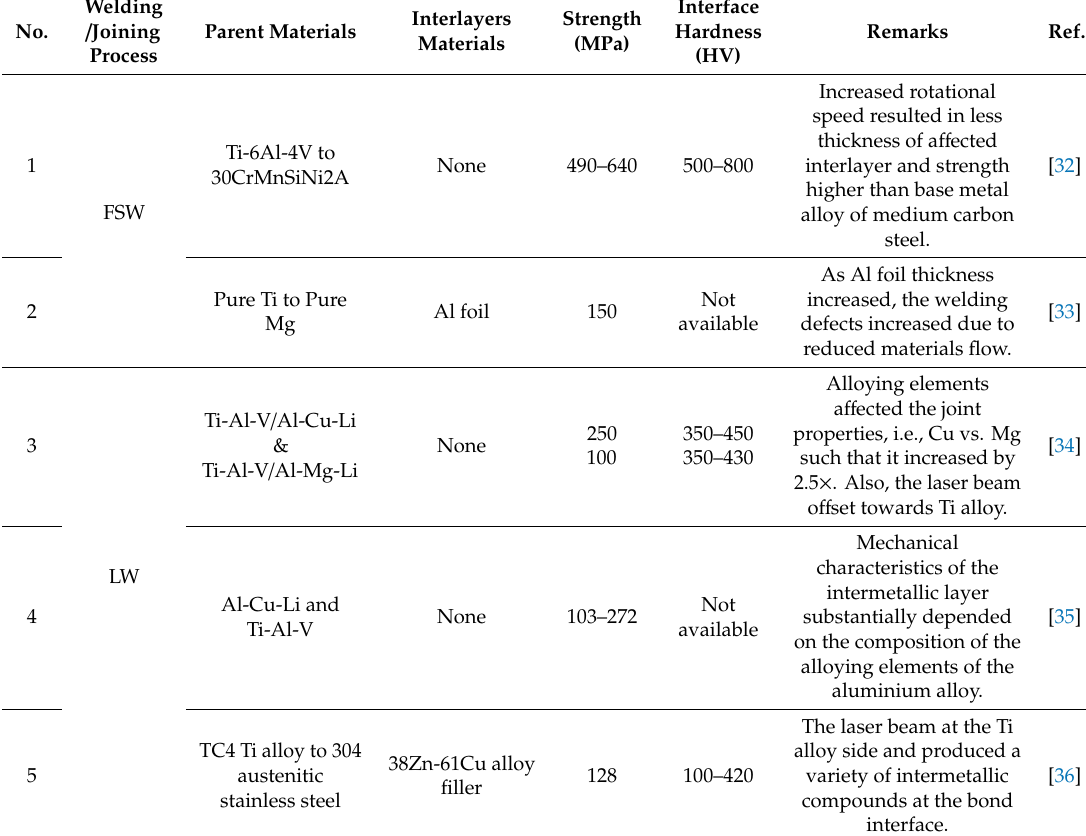
Table 1. Recent studies on dissimilar joining of Ti alloy utilizing different processes.